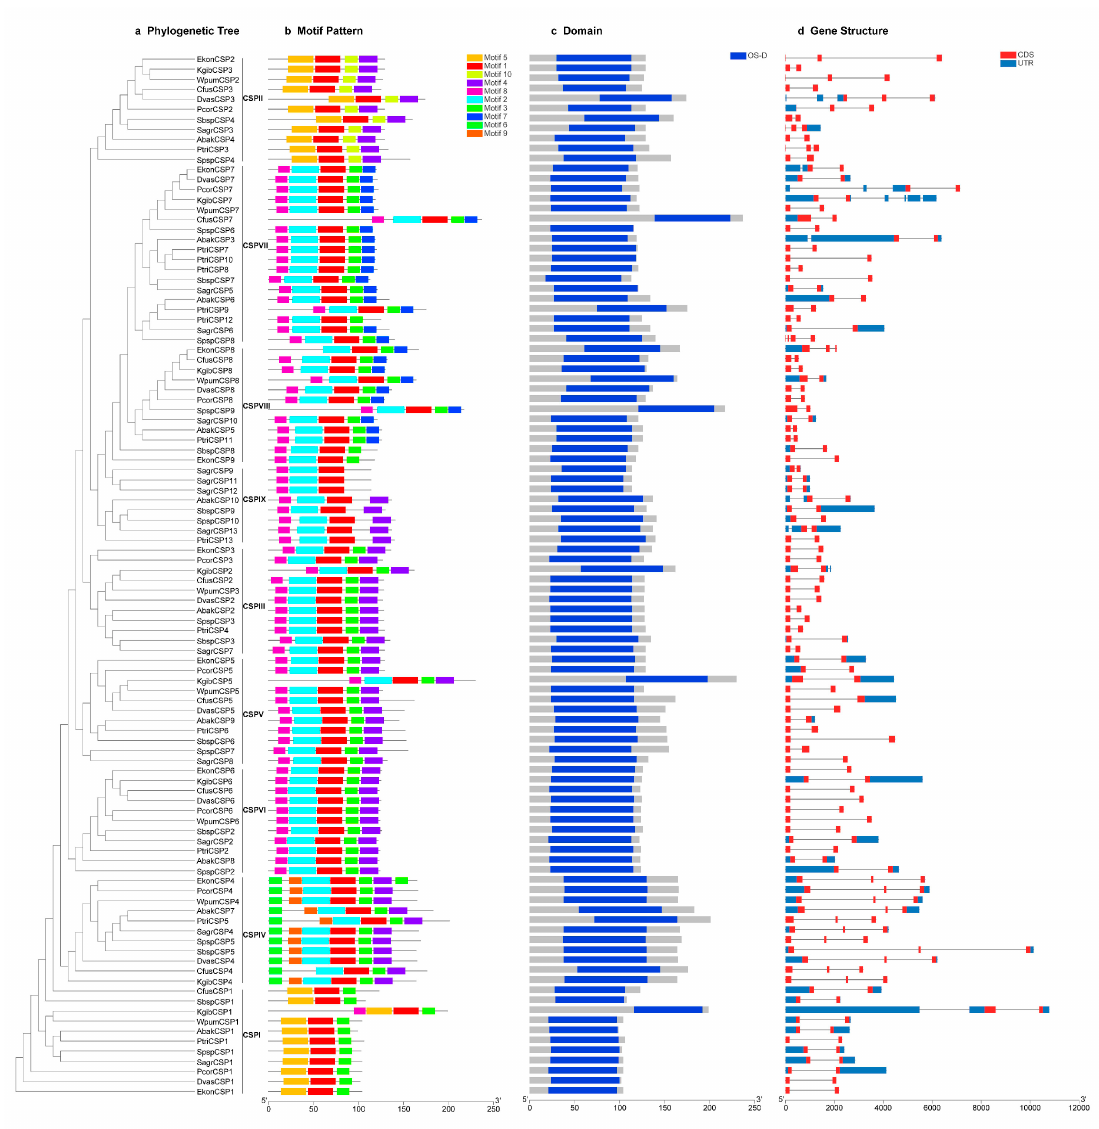
Figure 2. The 10 conserved motifs of 104 CSP genes in the 11 fig wasps. Four conserved cysteine residues (C1 – C4) correspond to the corresponding positions of motifs. X 6/8 indicate six or eight non-cysteine amino acids; X 18-19 indicate 18 to 19 non-cysteine amino acids; X 2 indicate two non-cysteine amino acids.